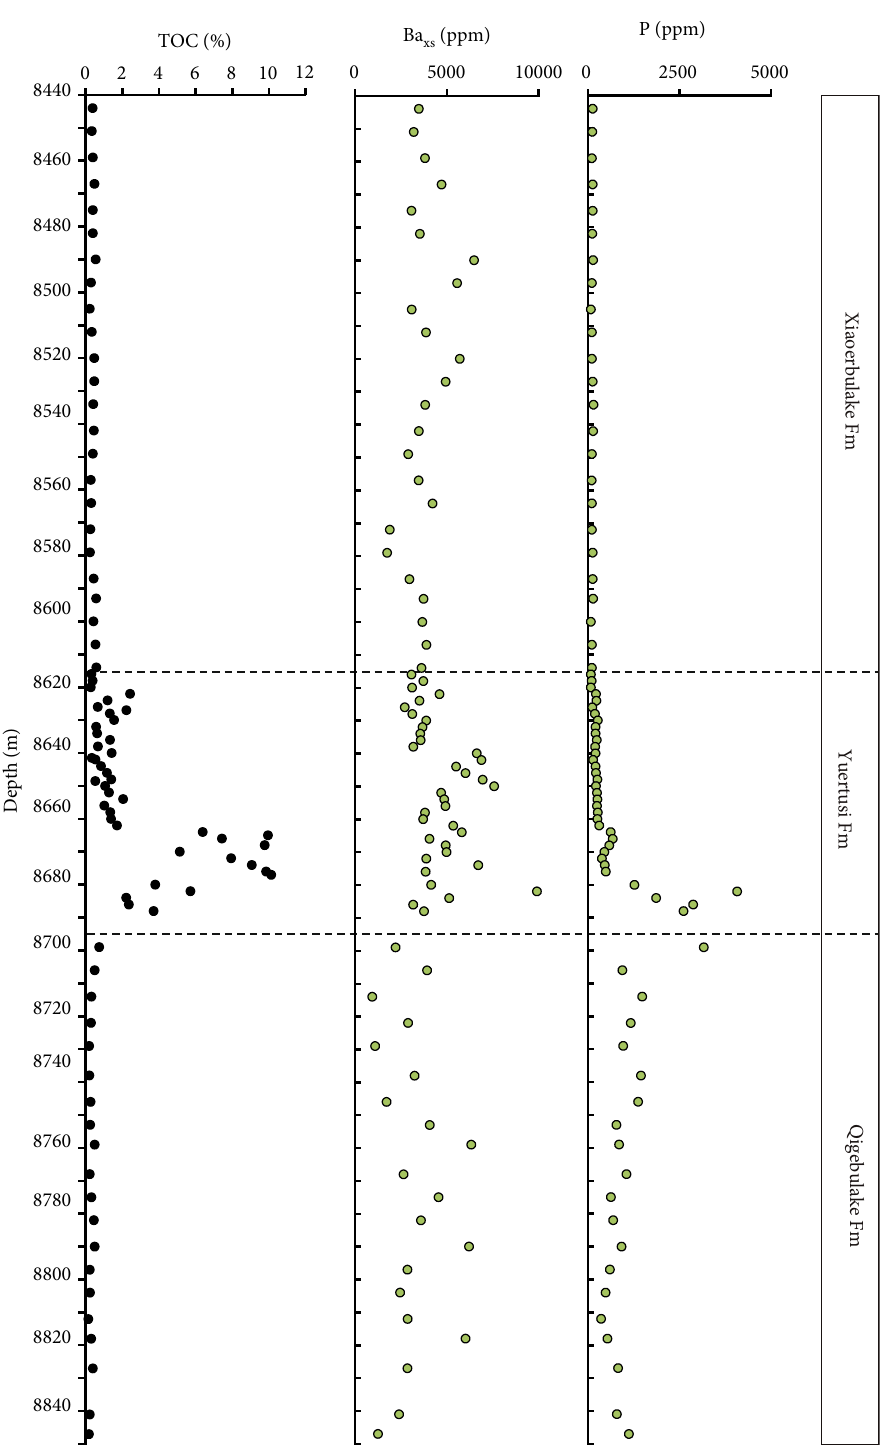
, and P content in well Luntan xs